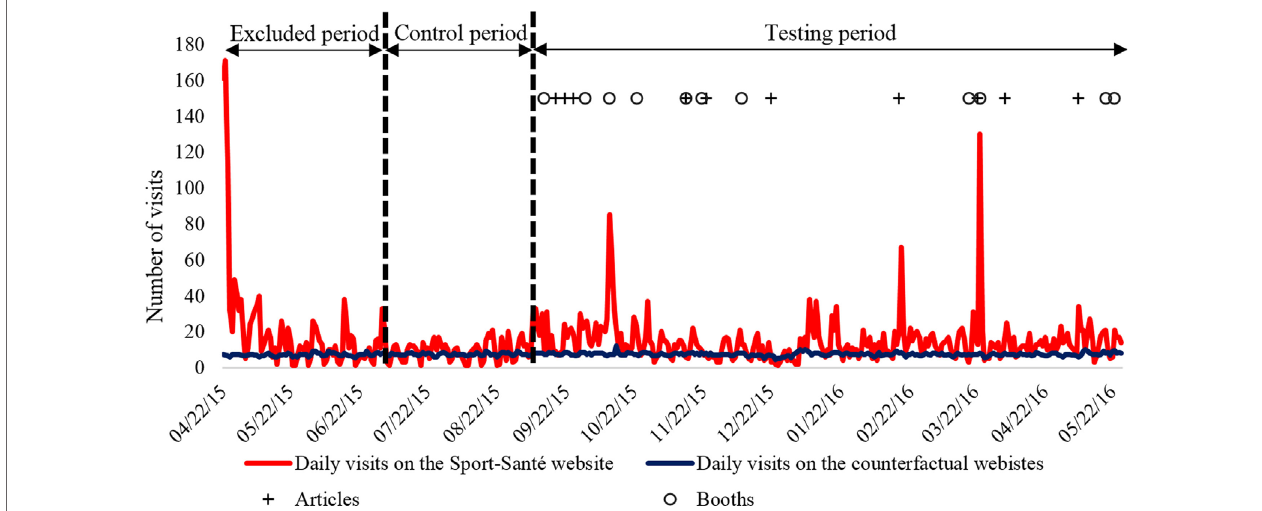
FigUre 2 | number of the daily visits on the sport-santé website (dark red line) and the counterfactual websites (dark blue line) from april 22, 2015 to May 25, 2016 . The period from the launch of the Sport-Santé website (April 22, 2015) to July 5, 2015 was excluded from the analysis. The period from July 5, 2015 to September 5, 2015 was considered as a control period. The effect of the advertising on the number of visits to the website was tested from September 5, 2015 to May 25, 2016 (testing period). The articles and the booths which promote Sport-Santé are identified by crosses and circles,